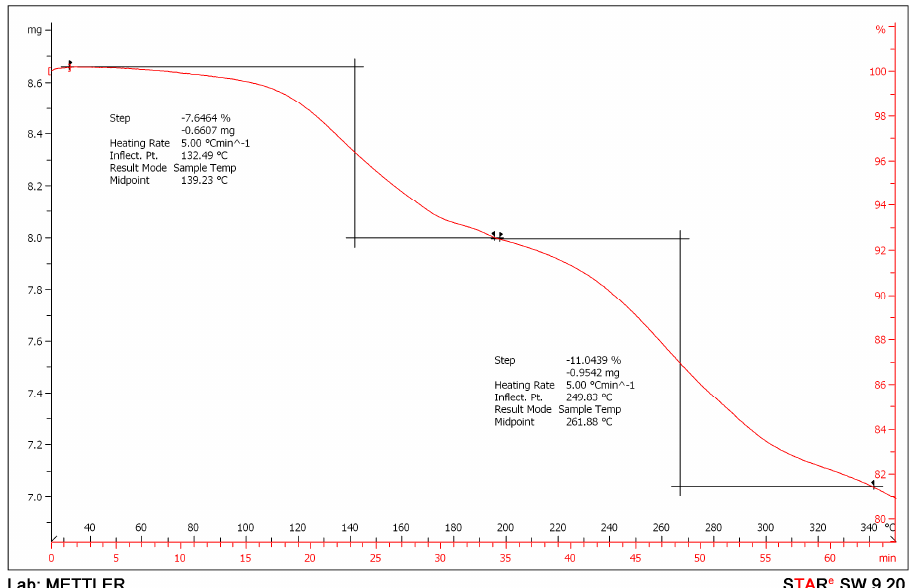
Figure 7. TGA of the title sample showing two mass losses. The first loss of 7.6% is desolvation, while the second loss is decomposition of the esomeprazole molecule.